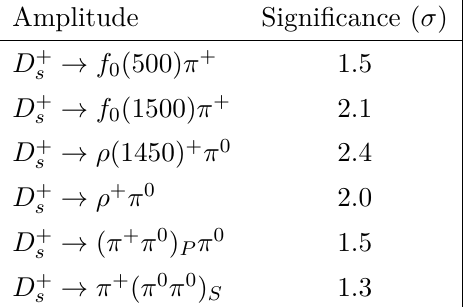
Table 5 . Significances of amplitudes tested, but not included in the nominal fit.